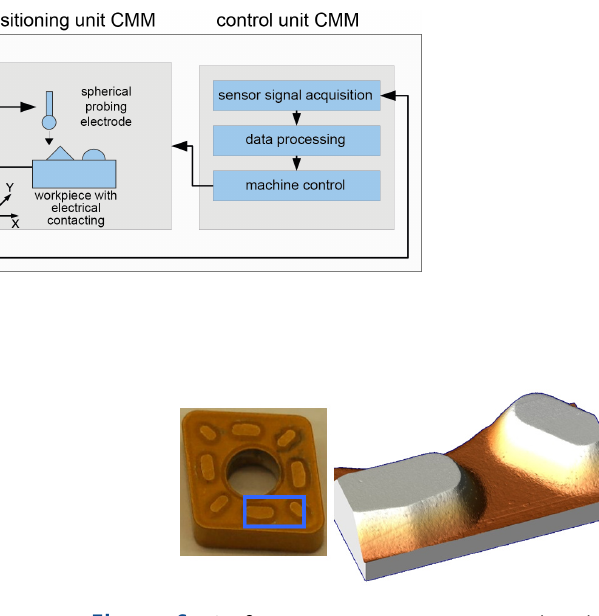
Figure 6. Surface measurement on a cutting insert, area 6mm ×